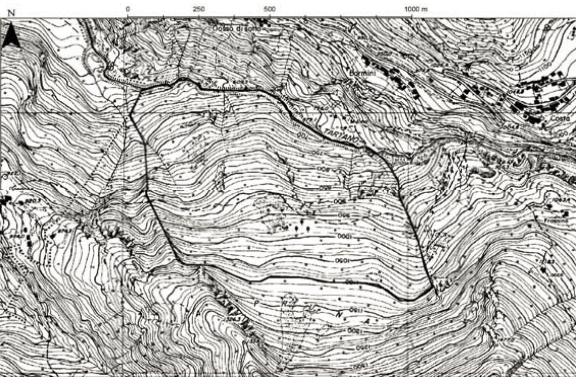
Figure 1. Map at scale 1:10,000 of the area of “Pruna Landslide” (Tartano Valley, Italy) proposed as case study for the assignments (lat: 46.130512°N; lon: